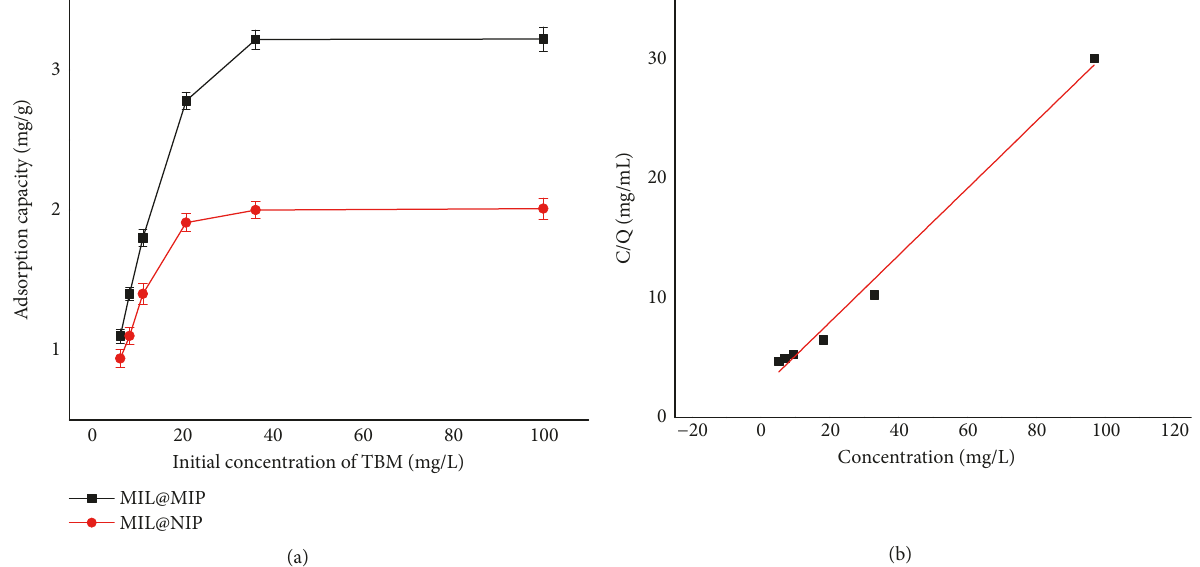
Figure 6: Binding isotherm of MIL@MIP and MIL@NIP for TBM in methanol (a) and Langmuir plot of MIL@MIP (b).